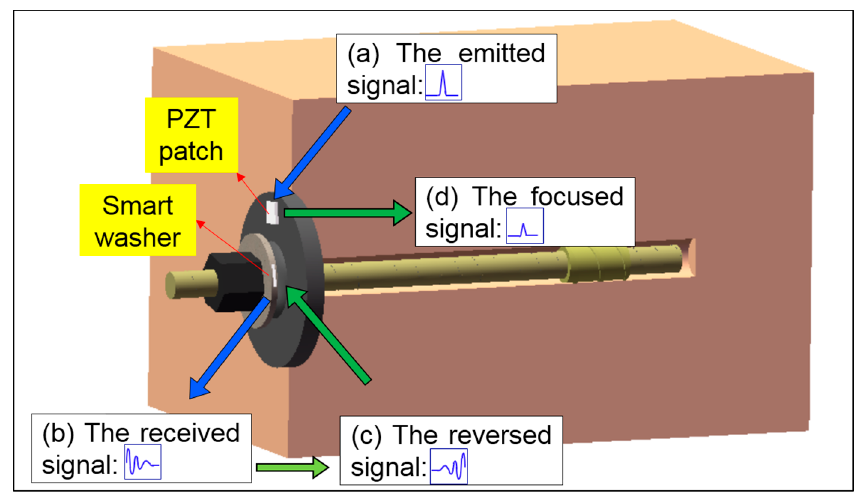
Figure 1. The time reversal pre-load monitoring a rock bolt.